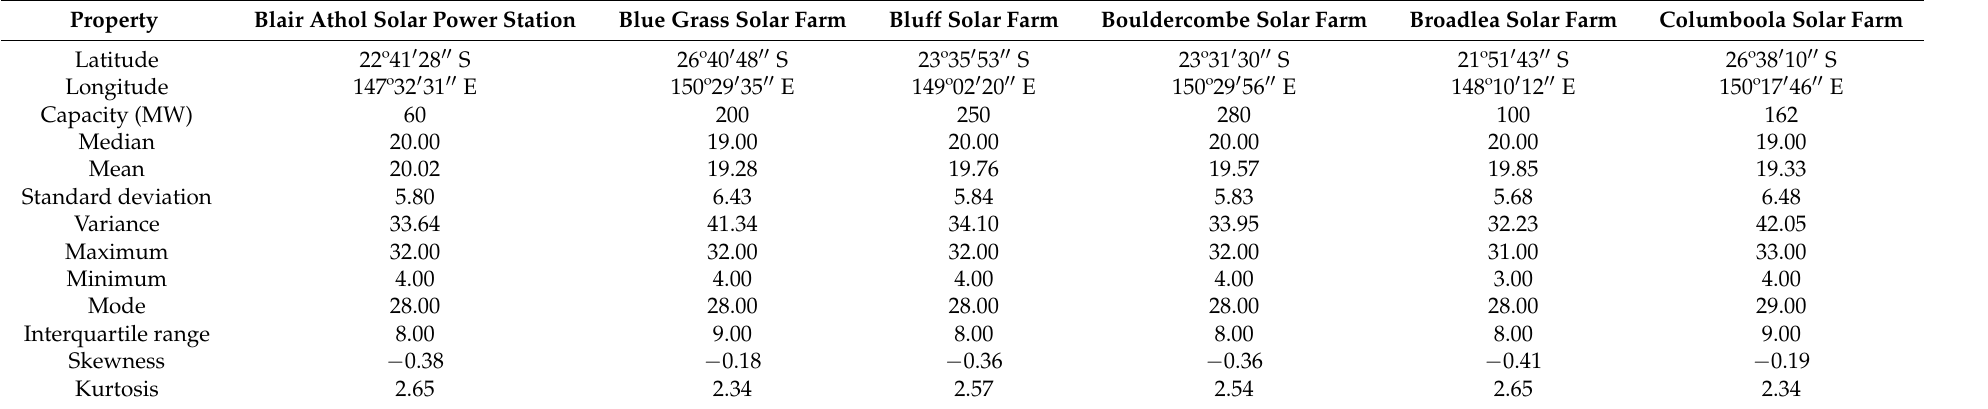
Table 1. Statistical summary of daily global solar radiation (GSR; MJm − 2 day − 1 ) in solar energy farms for Queensland Australia where the proposed deep learning hybrid SAELSTM model is